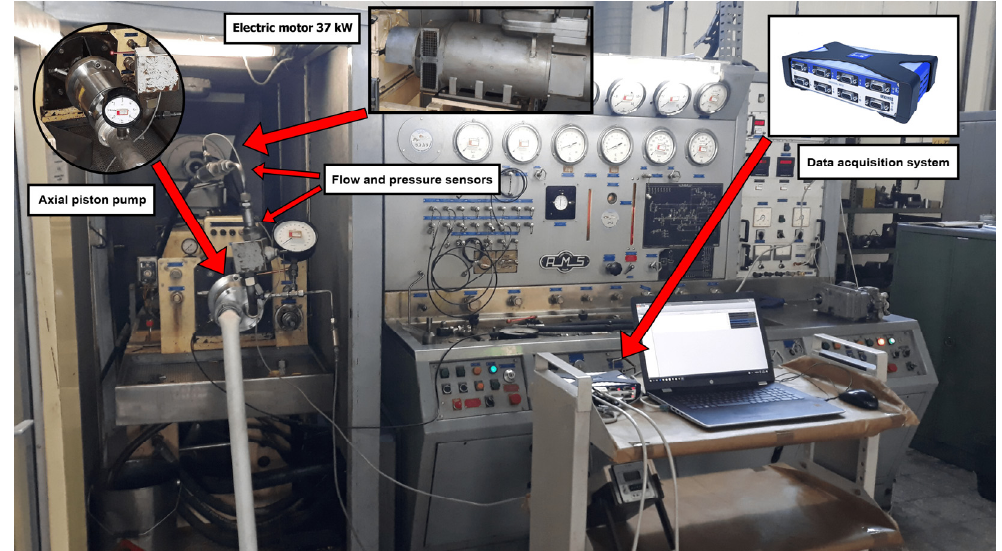
Figure 3. A picture of the test equipment.